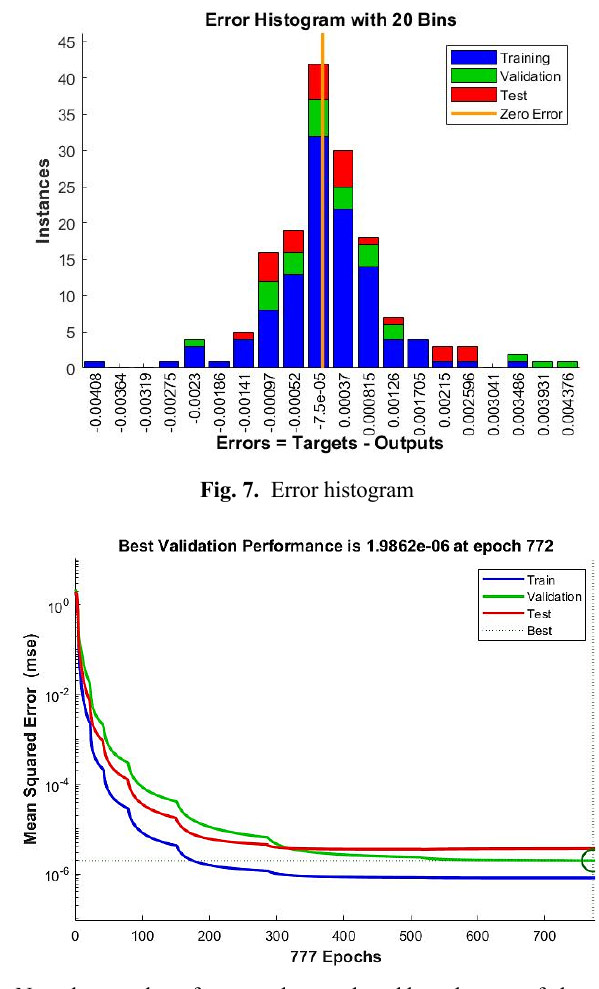
Fig. 8. Neural network performance by epoch and by subgroup of